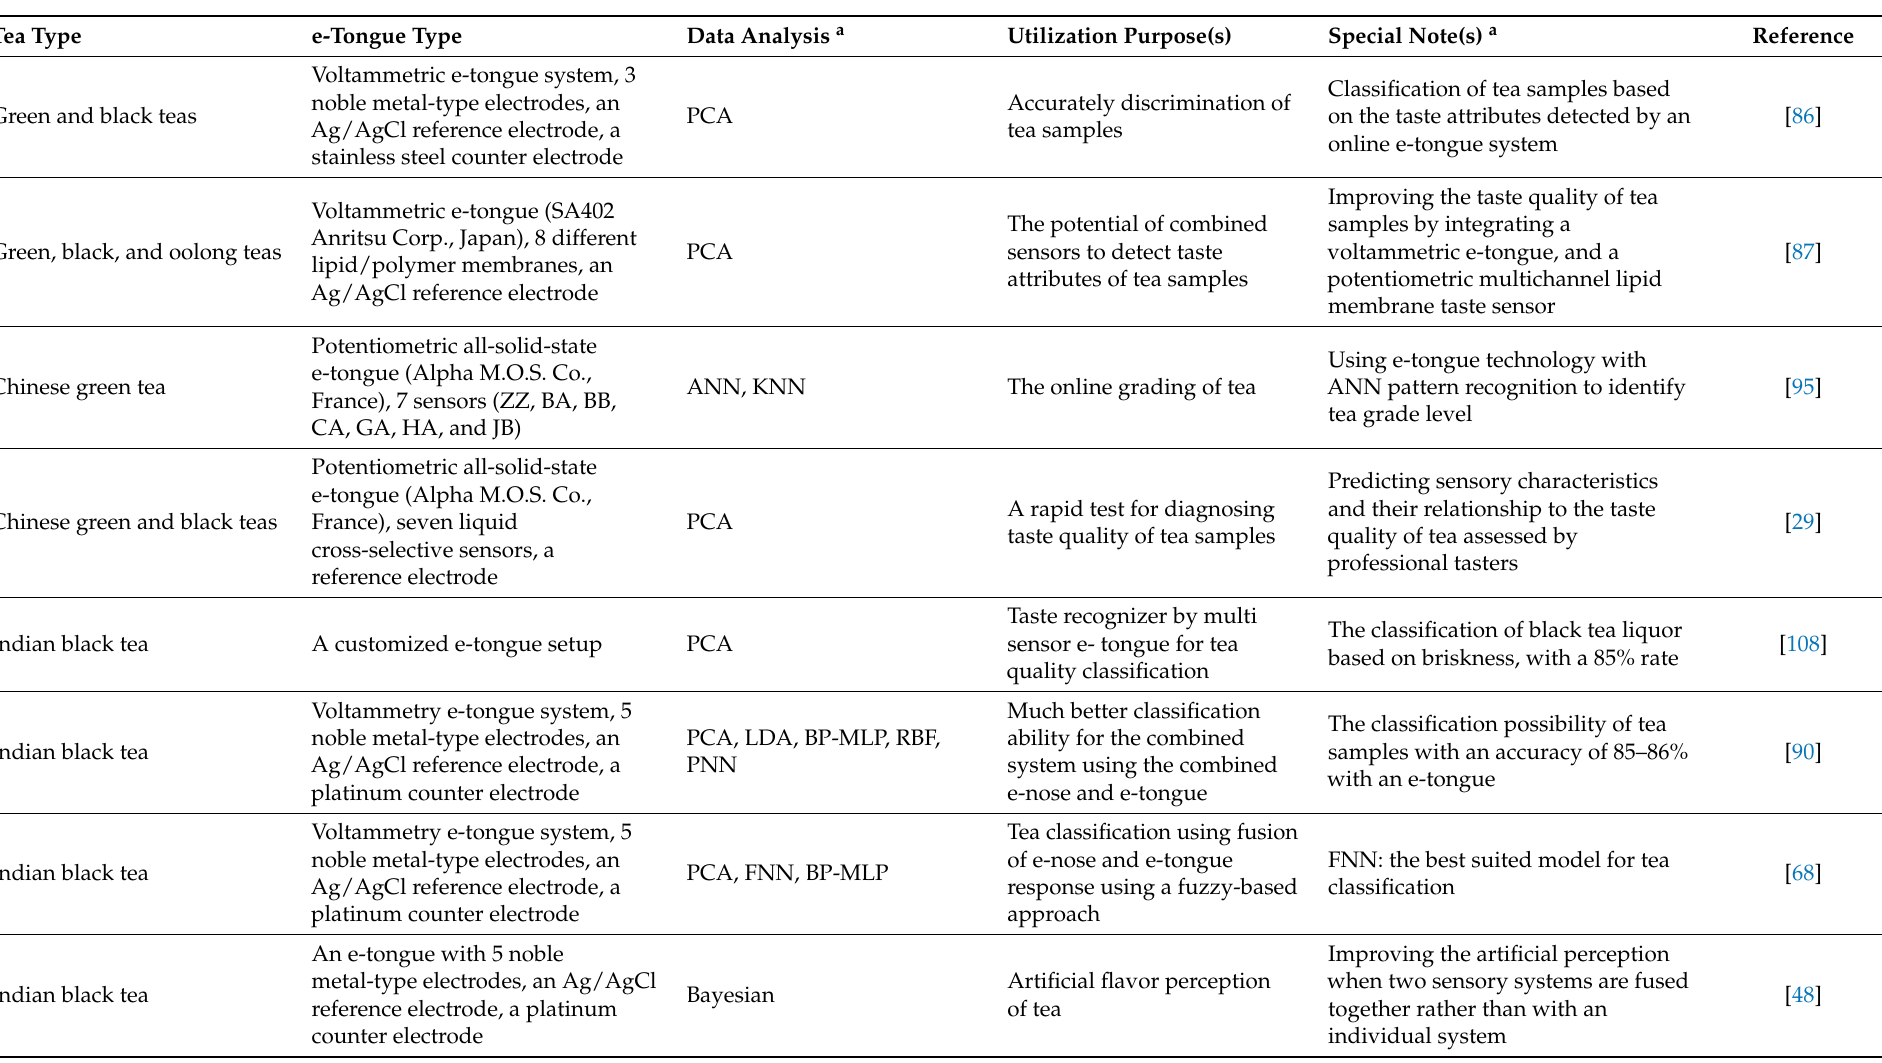
Table 2. The e-tongues used to analyze the sensory quality factors in different types of